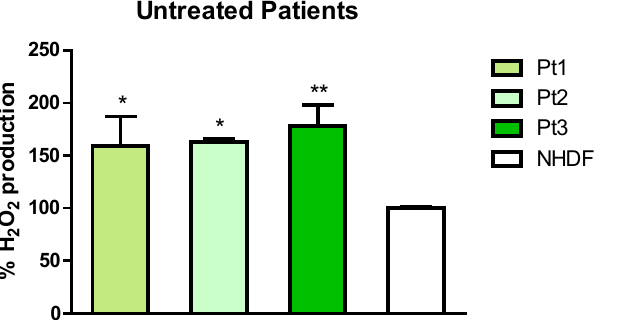
Figure 3. ROS production in untreated patients and NHDF. Production of intracellular ROS was